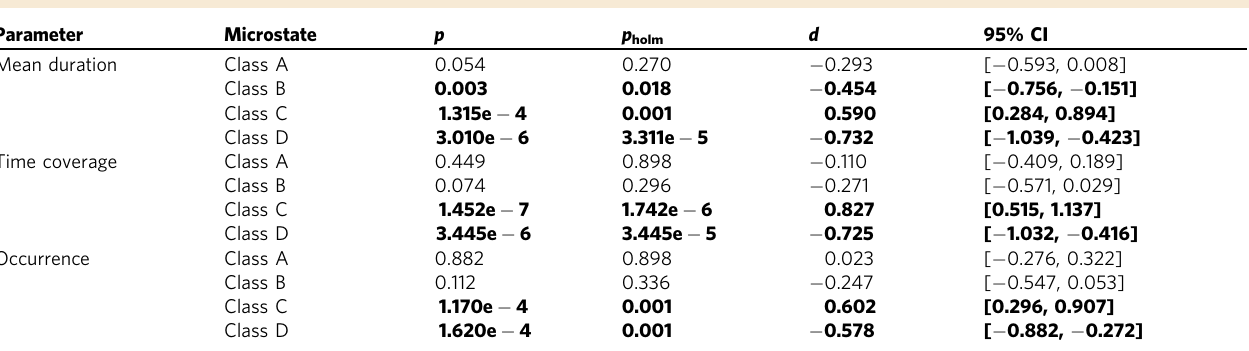
Posthocpairwisegroup comparisonsof EEGmicrostatedynamicsof patients( n = 101)andcontrols ( n = 75). p values referto maineffectsof groupfollowingGroup×Gender ANCOVAswithEducation as a covariate; degrees of freedom (df) of the numerators are 1 and df for the denominators are 171. p holm values refer to Bonferroni – Holm corrected p values for 12 comparisons (3 parameters×4 classes). η 2 ′ s were converted to Cohen ′ s d ’ s. Statistically signi fi cant differences are indicated in